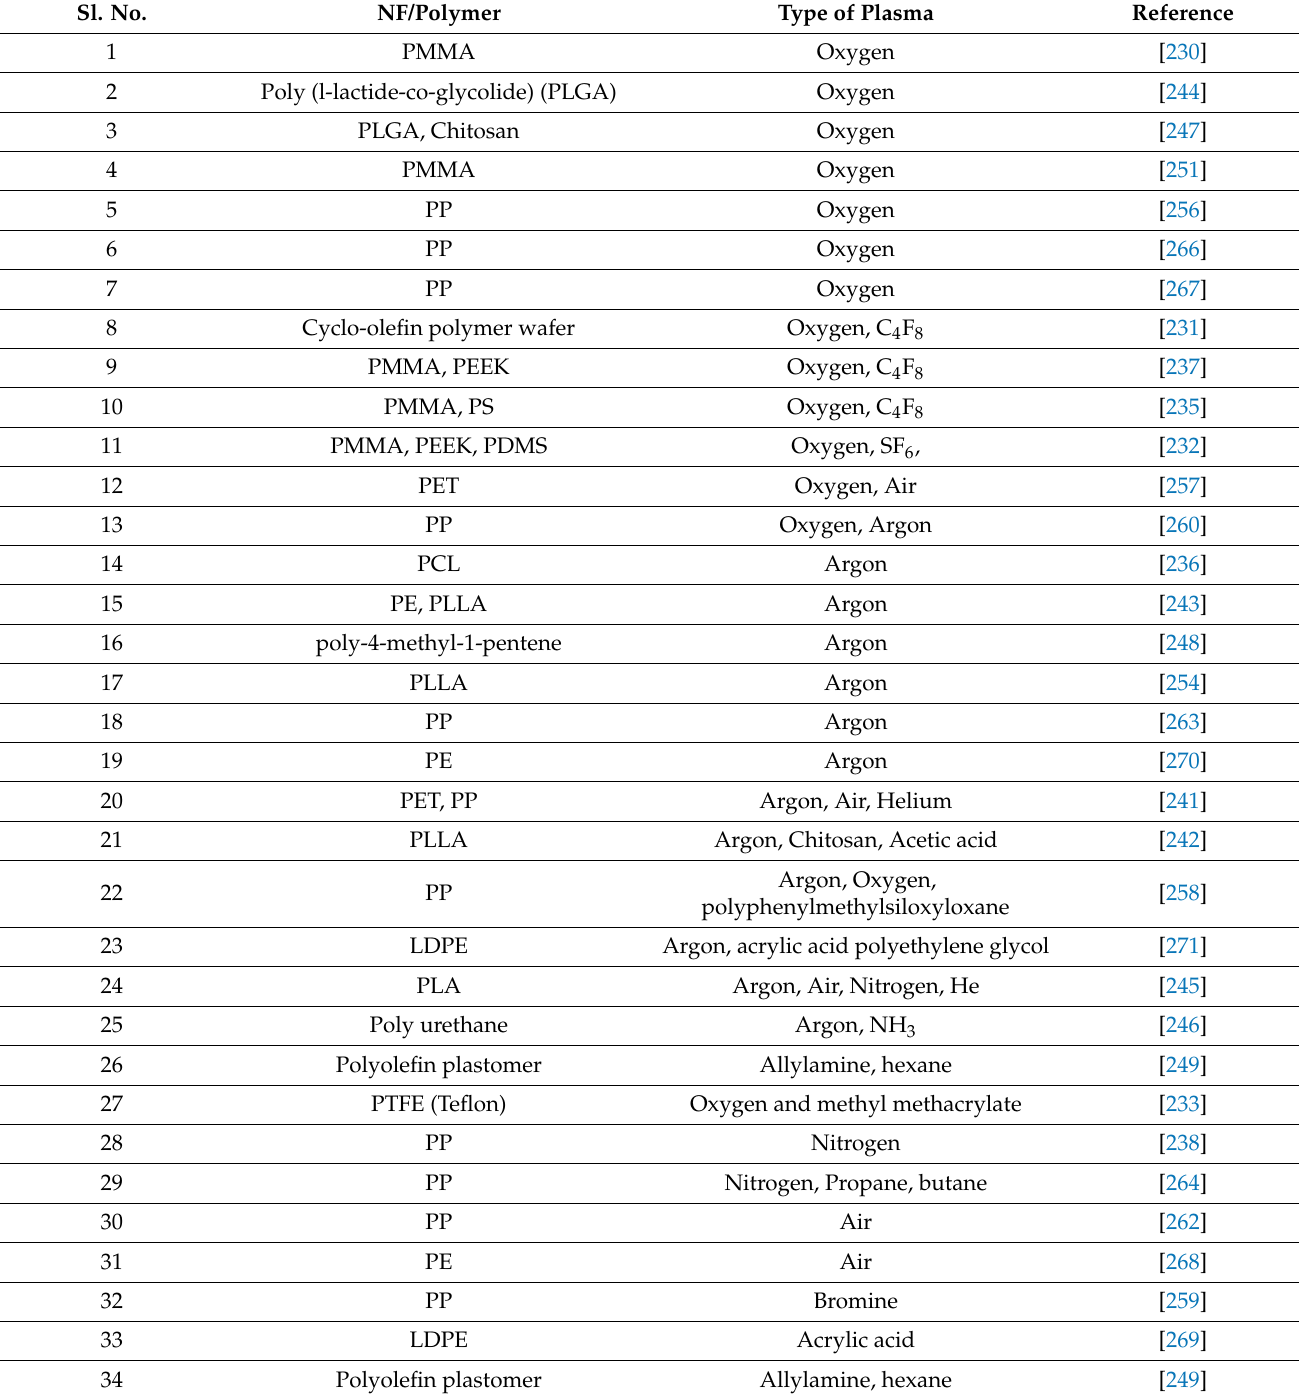
Table 5. Reported some studies of plasma-treated polymers for biomedical applications. Sl.